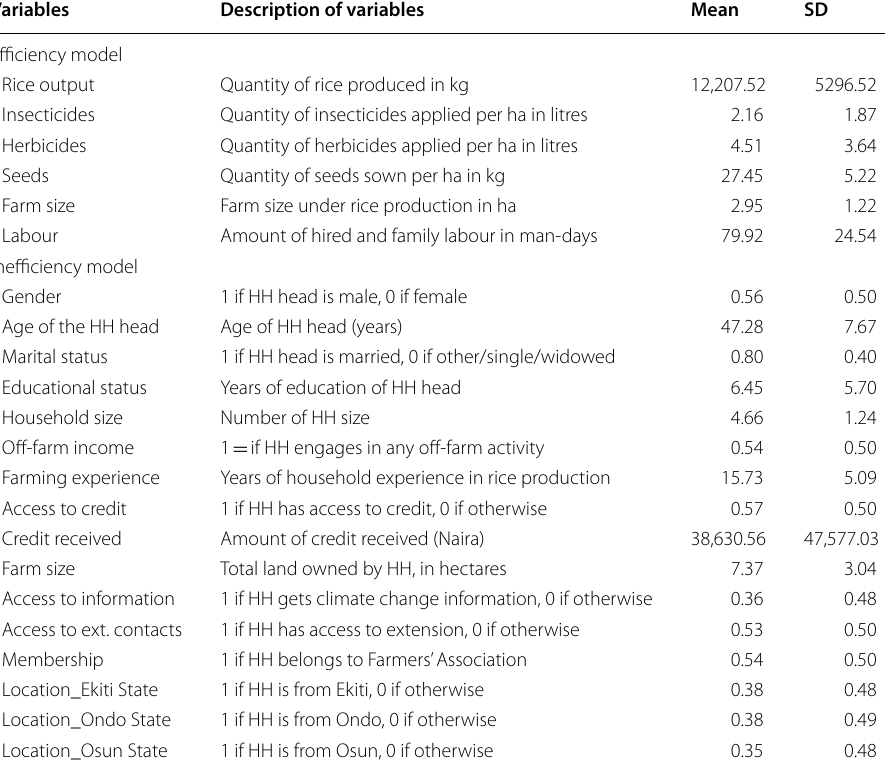
Table 1 Definitions and summary statistics of variables used in the model Variables Description of variables Mean SD Efficiency